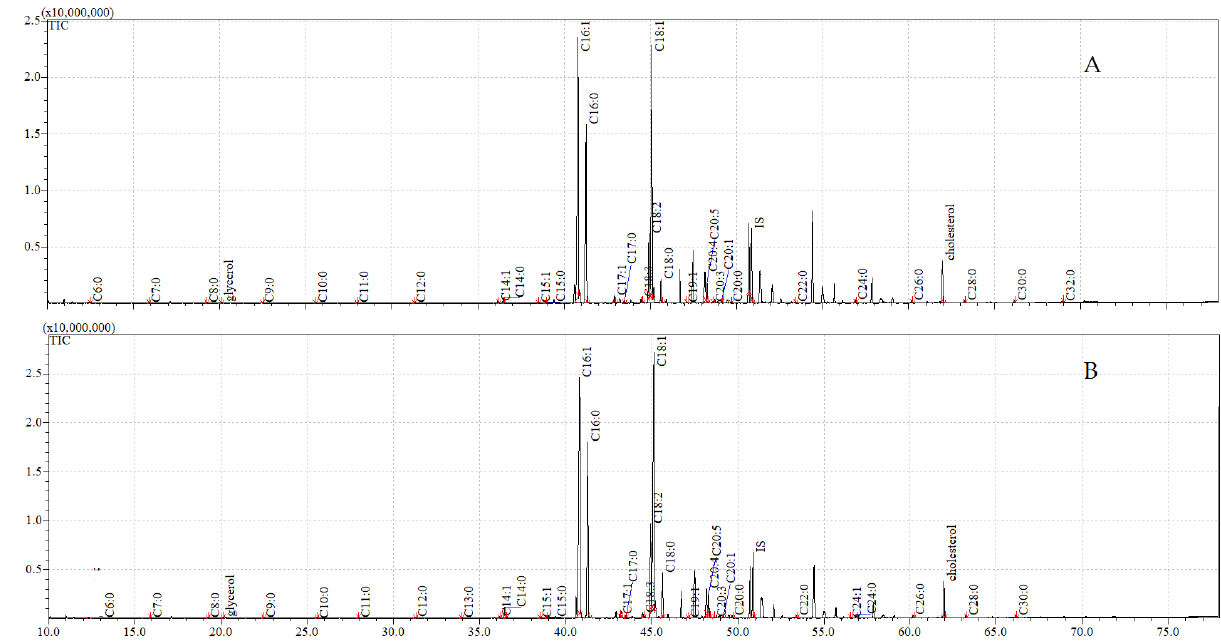
Figure 6. The total ion current (TIC) chromatogram of fatty acids (TMS esters) of the dichloromethane extract (extract